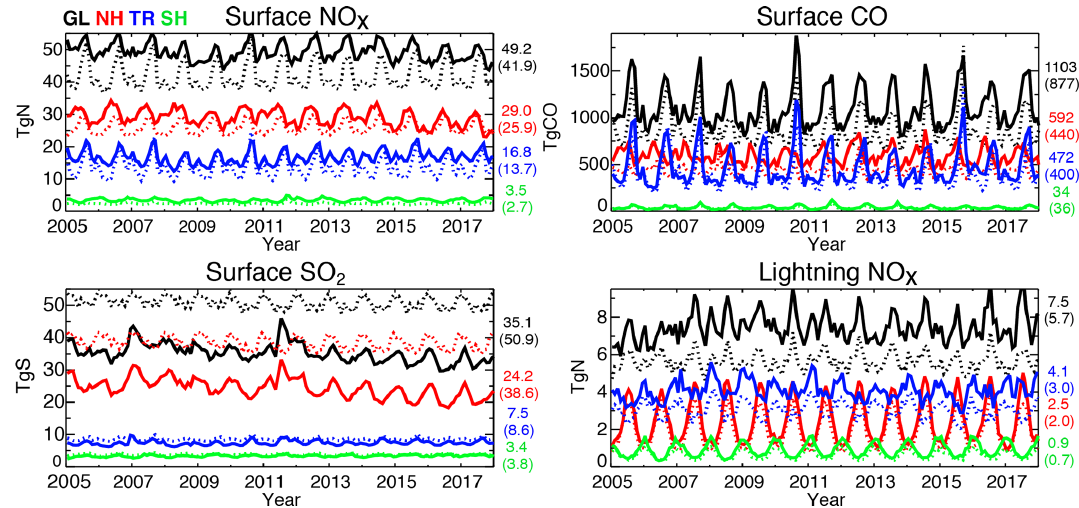
Figure 13. Time series of monthly total global and regional surface NO x emissions (in TgNyr − 1 ), surface CO emissions (in TgCOyr − 1 ), surface SO 2 emissions (in TgSyr − 1 ), LNO x emissions (in TgNyr − 1 ), and obtained from the reanalysis (solid lines) and the emission inventories or the control run (dashed lines) over the globe (90 ◦ S–90 ◦ N), NH (20–90 ◦ N), tropics (TR, 20 ◦ S–20 ◦ N), and SH (90–20 ◦ S). The mean emissions values obtained from the reanalysis run and the emission inventories (in bracket) averaged over the years 2005–2018 are shown on the right-hand